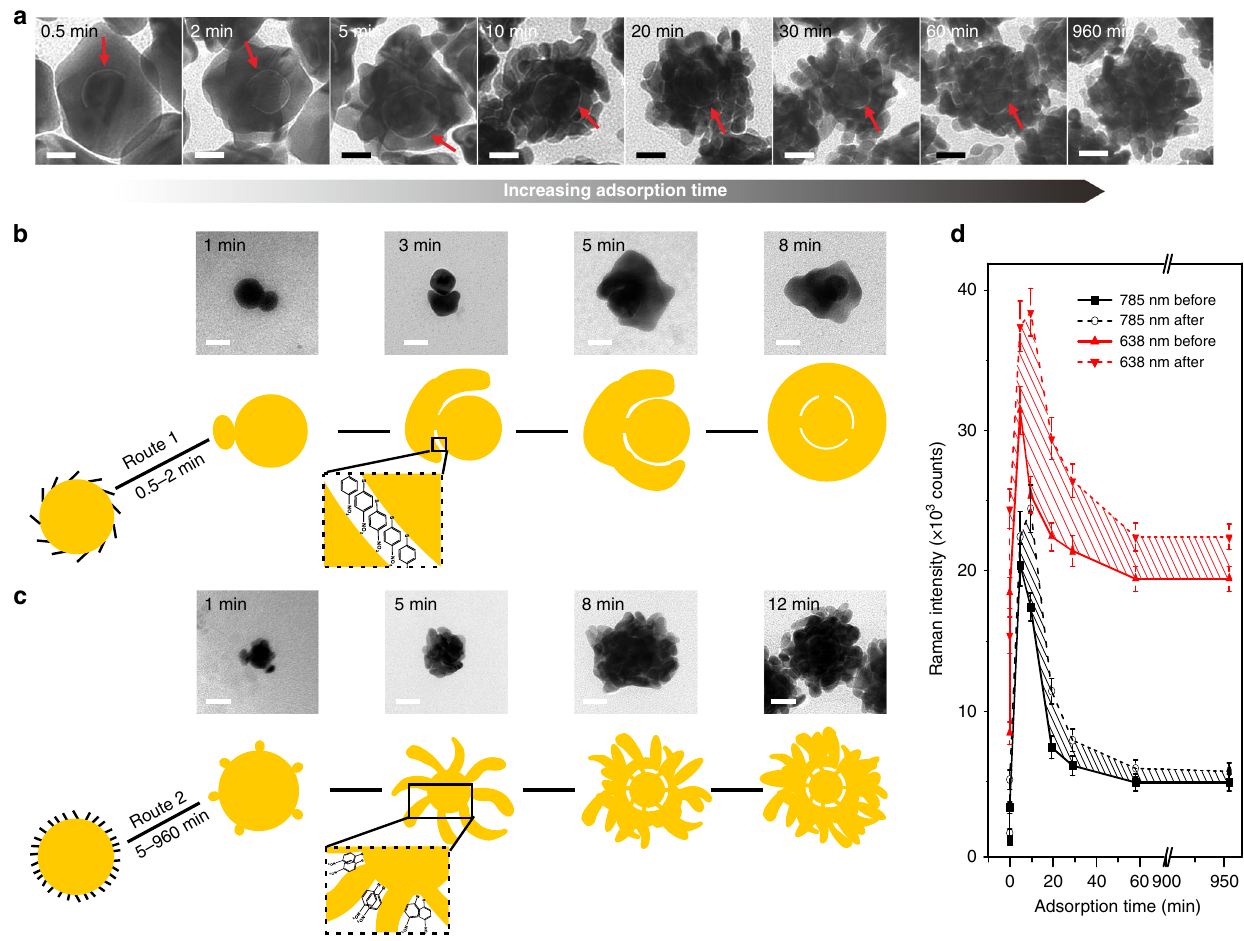
Fig. 2 Highly tunable morphology of P-GERTs. a Representative TEM images of P-GERTs as a function of incubation time (0.5, 2, 5, 10, 20, 30, 60, and 960 min, respectively) of Au core and Raman reporter 4-NBT. Red arrows indicate the internal nanogaps of P-GERTs. Presumed growth process of the Au shell on b low-density and c high-density 4-NBT decorated Au cores, with corresponding time-lapse TEM examinations. All scale bars are 20 nm. d Comparison of mean SERS intensity before and after 4-NBT molecules decoration on the external surface of P-GERTs with various morphologies excited by 785 nm (black) and 638 nm (red) laser. Error bars are standard deviations from three independent measurements. Source data are provided as a Source Data fi